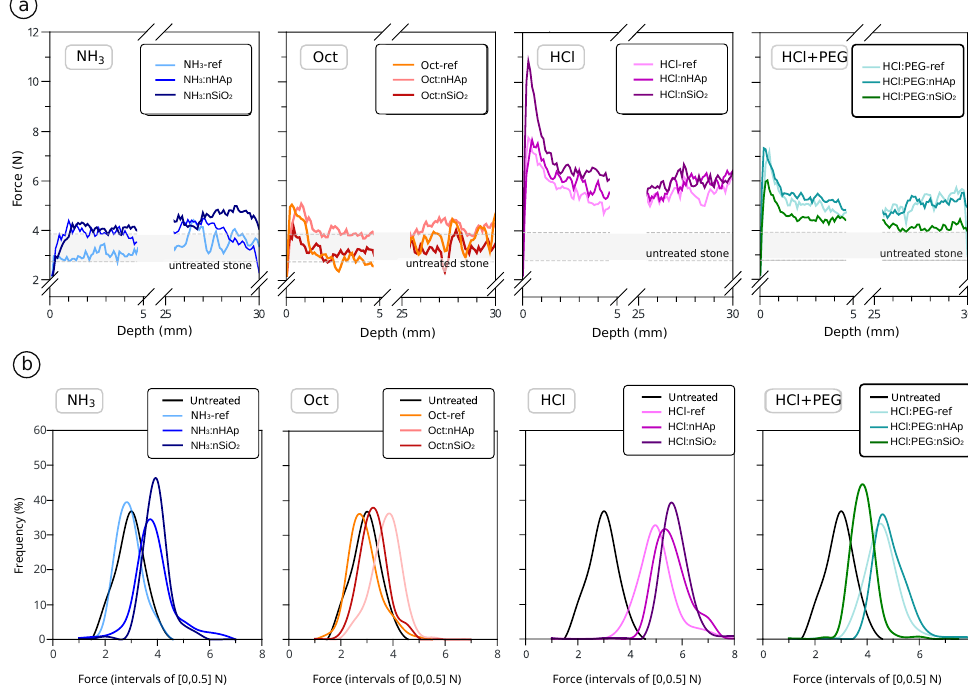
Figure 4. Drilling resistance average profiles ( a ) and respective histograms ( b ): comparison and evaluation of the influence of the prepared formulations on the resistance of treated sound samples, separated by different catalysts, in relation to the untreated